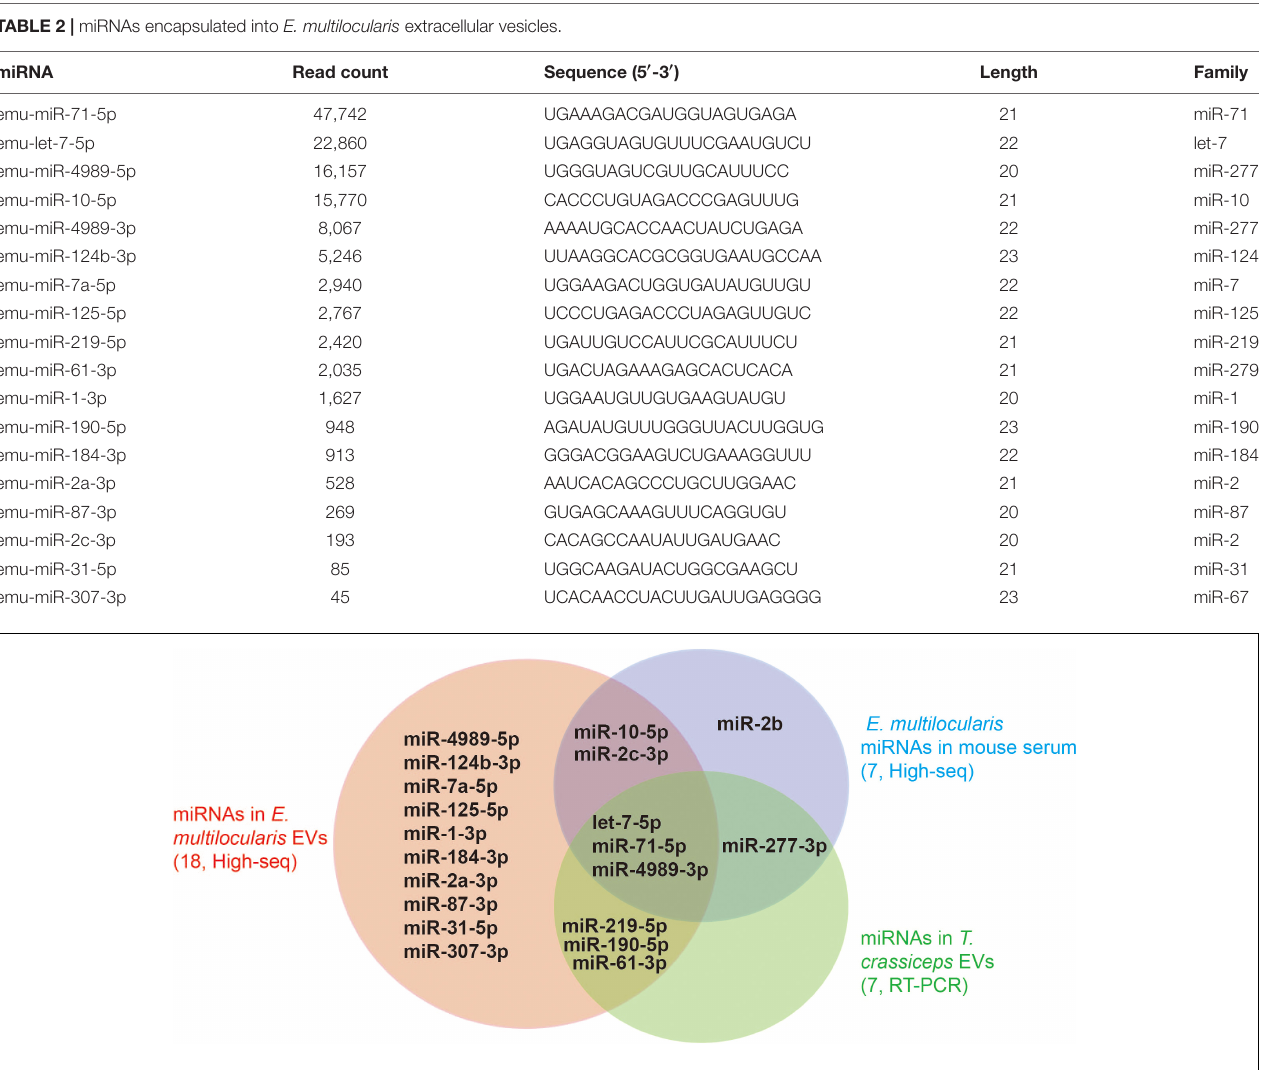
FIGURE 2 | miRNAs identified in E. multilocularis extracellular vesicles. Extracellular vesicle miRNA cargoes encompassed the majority of miRNAs that were identified in the sera of E. multilocularis -infected mice by high-throughput sequencing (High-seq), and in T. crassciceps extracellular vesicles by reverse-transcription PCR (RT-PCR). The numbers in brackets stand for the total number of miRNAs identified in each study. EVs, extracellular vesicles.